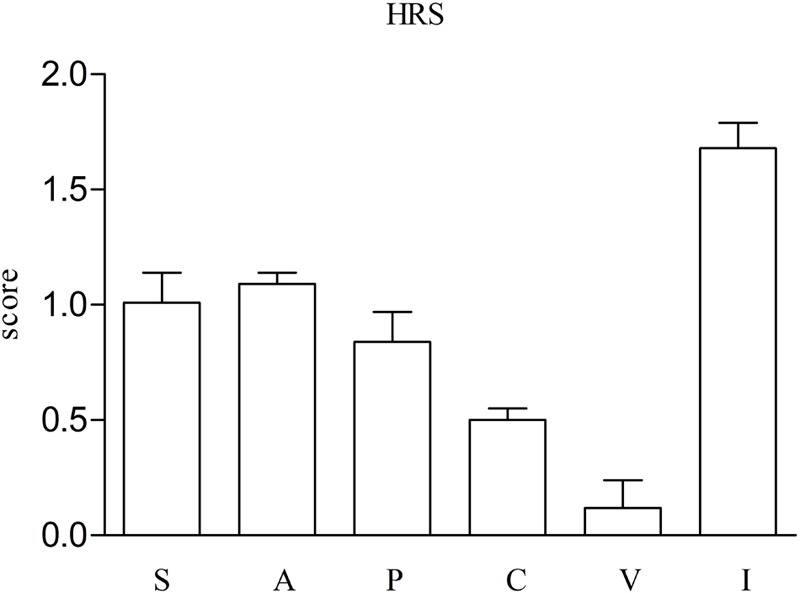
Scores on The Hallucinogenic Rating Scale (HRS) questionnaire subscales (n = 16, mean, standard error). Scores represent the maximum effects along 6 h after self-administration of 2C-B. S: somaesthesia; A: affect; P: perception, C: cognition; V: volition, I: intensity.